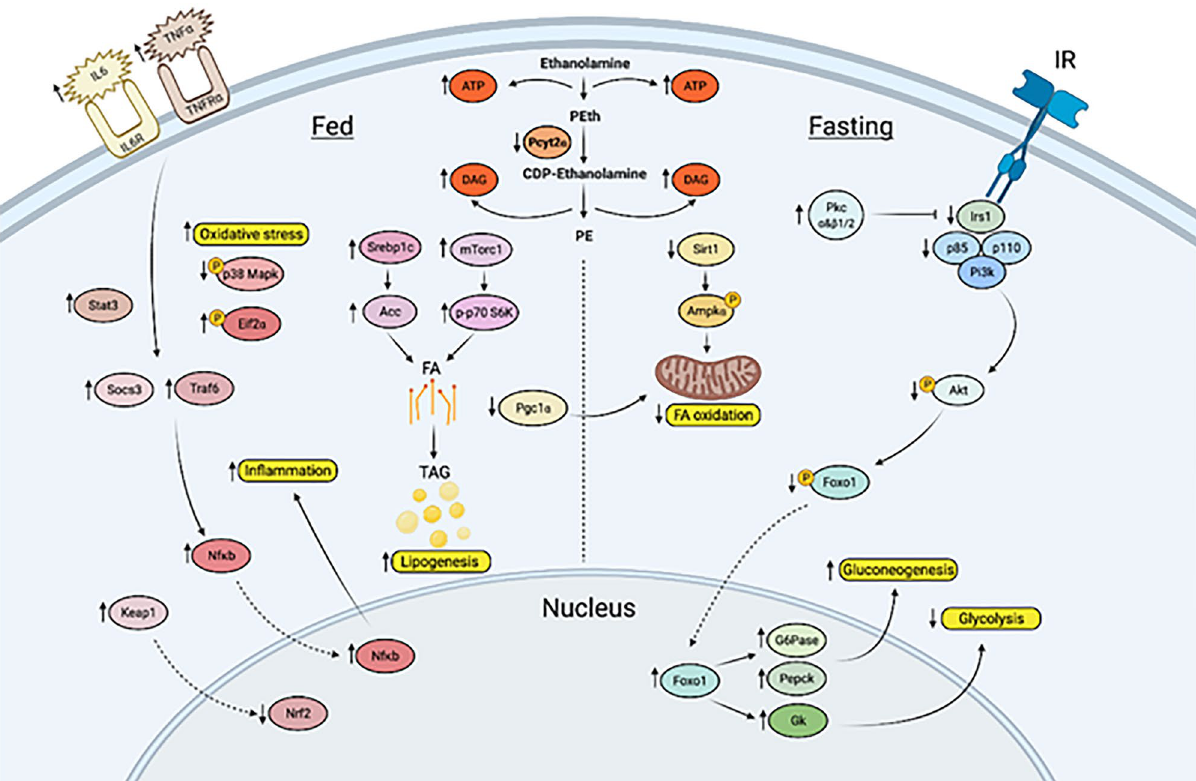
Figure 7. Working model for age-dependent development of Pcyt2 + /− hepatic steatosis and inflammation, and reversion with PEtn. Image was created with